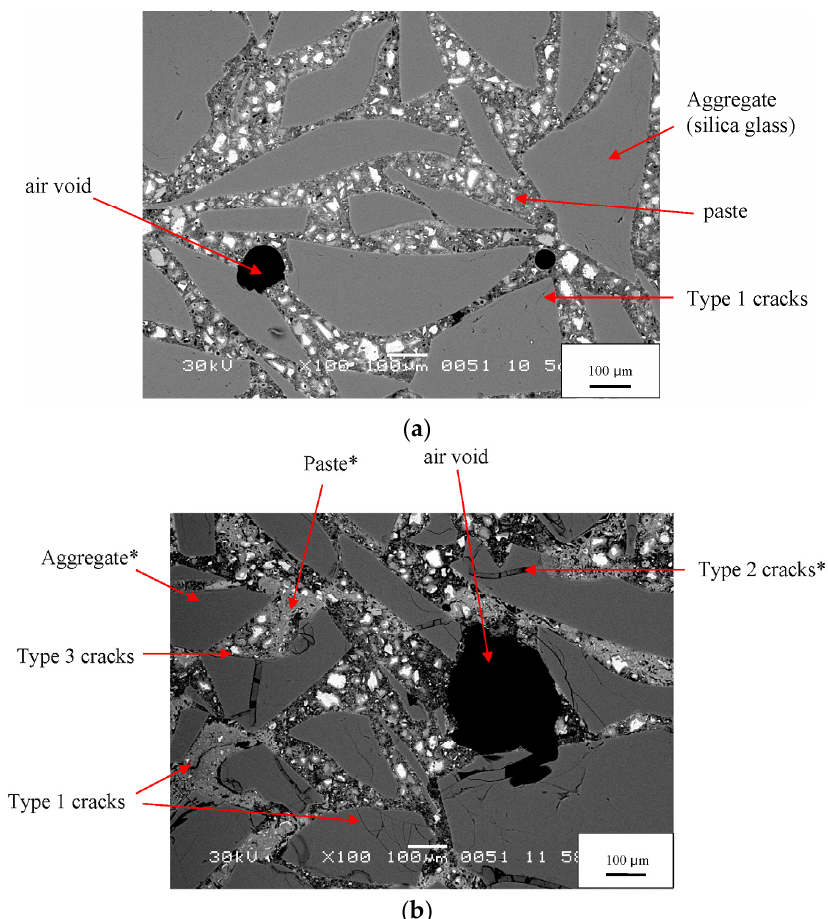
Figure 4. BSE images of a mortar at 0 days ( a ) and at 21 days ( b ). The white boxes in Figure 3a,c show where in the montage these two images were taken. Labels are explained in the text. Note: * denotes constituents whose EDX data are provided in Table 4.